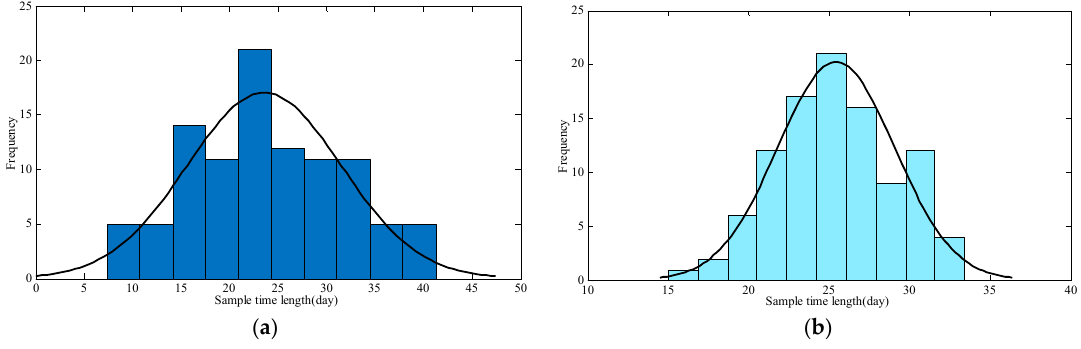
Figure 9. The frequency distribution of the sampling time length reaching to the demand of energy storage systems. ( a ) The required maximum power corresponding to the sampling time length; ( b ) The required maximum capacity corresponding to the sampling time length.